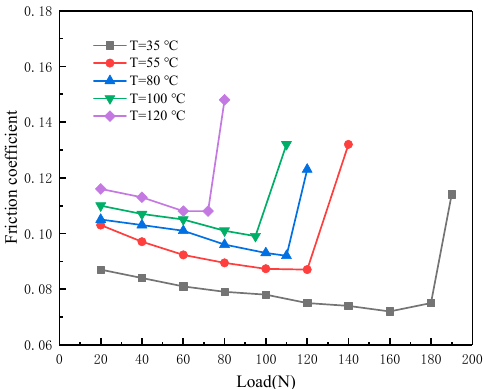
Figure 5. Variation of friction coefficient with sliding speed.